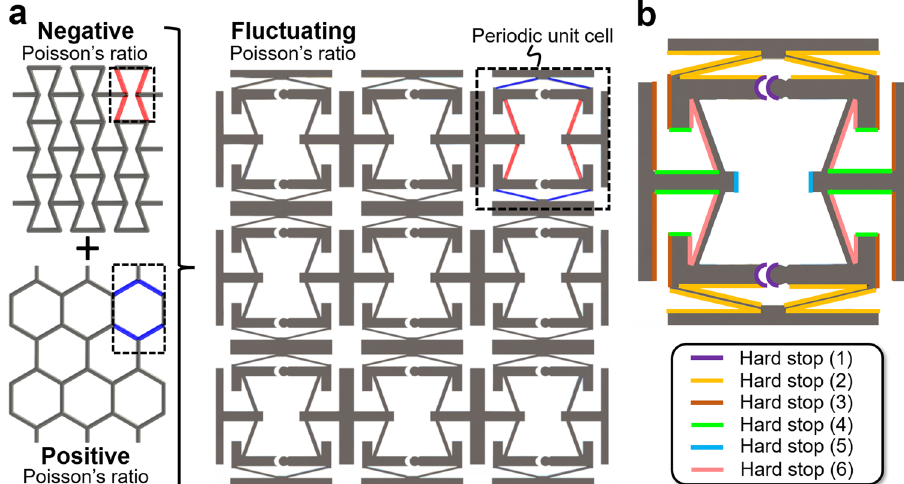
Fig. 1 Sequential metamaterial that achieves an alternating Poisson ’ s ratio. a The concept is inspired by the inward (red) and outward (blue) facing beams of the famous negative and positive Poisson ’ s-ratio honeycomb designs, respectively. b The design achieves its alternating Poisson ’ s ratio due, in part, to six hard stops that collide and then redirect the motions of each unit cell rigid